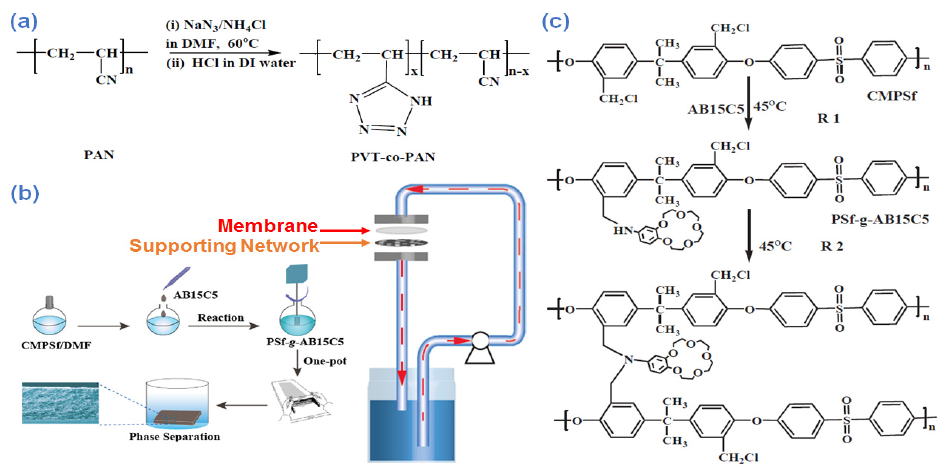
Figure 21. ( a ) Coupling polyvinyltetrazole with PAN via (3 + 2) cycloaddition process at 60 °C [201], ( b ) preparation of PSf-g-AB15C5 membrane along with a view of the dynamic adsorption process, and ( c ) the crosslinking and grafting reaction during the formation of PSf-g-AB15C5 [208]. Reproduced with permission from [208], copyright of